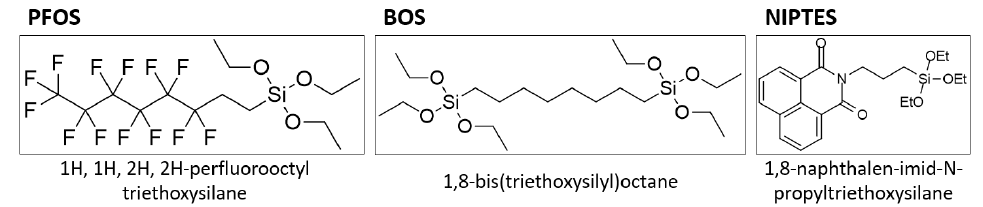
Figure 4. Chemical structures of the applied organosilanes PFOS, BOS and NIPTES.